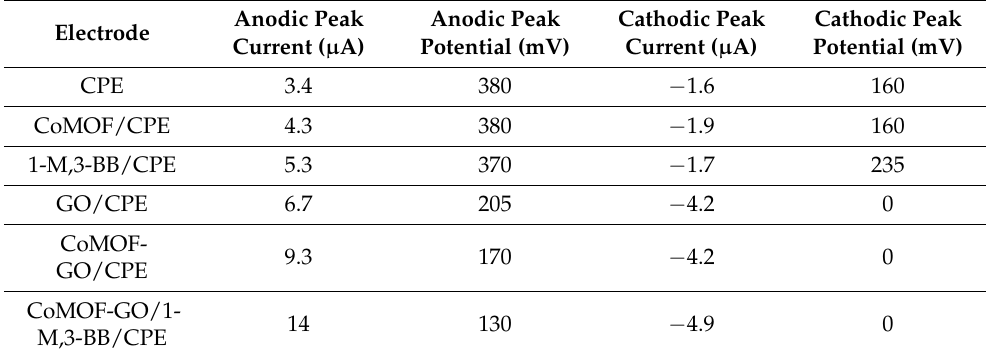
Table 1. Comparison of the electrochemical oxidation of DA (150.0 µ M) in PBS (0.1 M; pH = 7.0) on the surface of various